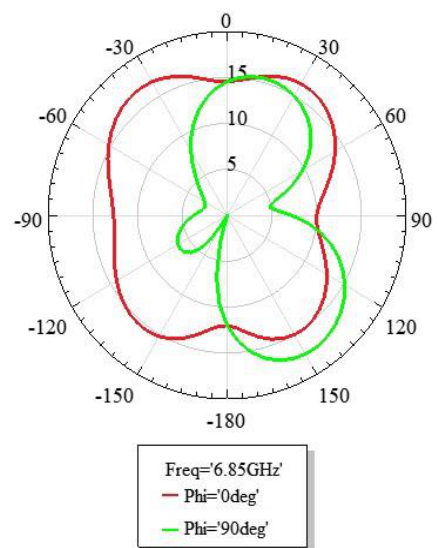
Fig. 7. E-plane and H-Plane Radiation Pattern of HMSA at 6.85 GHz